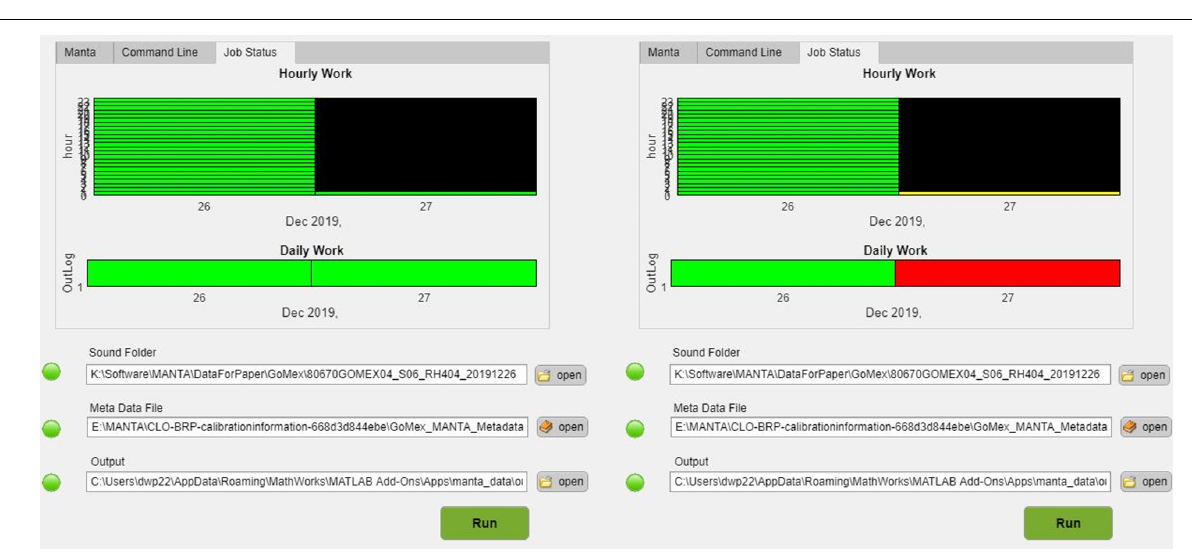
FIGURE 6 | Color-coded performance report of the audio processing. (Left) Reports with all green indicate no missing data or processing errors upon completion of processing. Black sections indicate time periods with no data. (Right) Report of mid-processing job status. Yellow indicates data that is currently being processed, and red indicates data in the